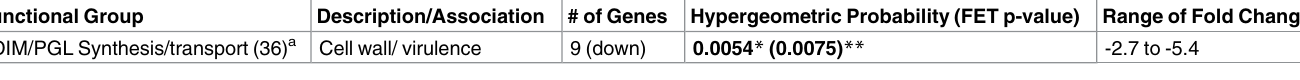
Table 4. Virulence-associated cell wall synthesis and transport. Functional Group